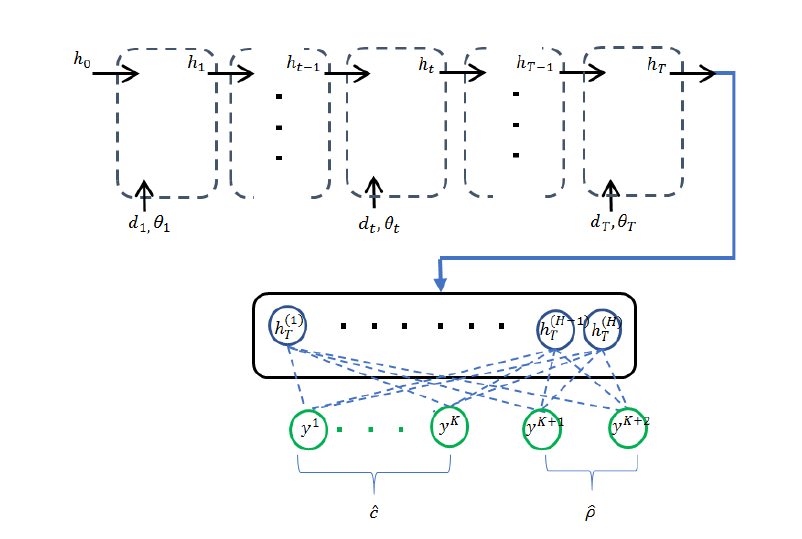
Figure 2. The network architecture of the recurrent neural network with confidence measure (RNN-CM). The boxes in the first row are long short-term memory (LSTM) cells, and the hidden state of the last cell is fed to a fully connected neural network. The superscripts are element indices of